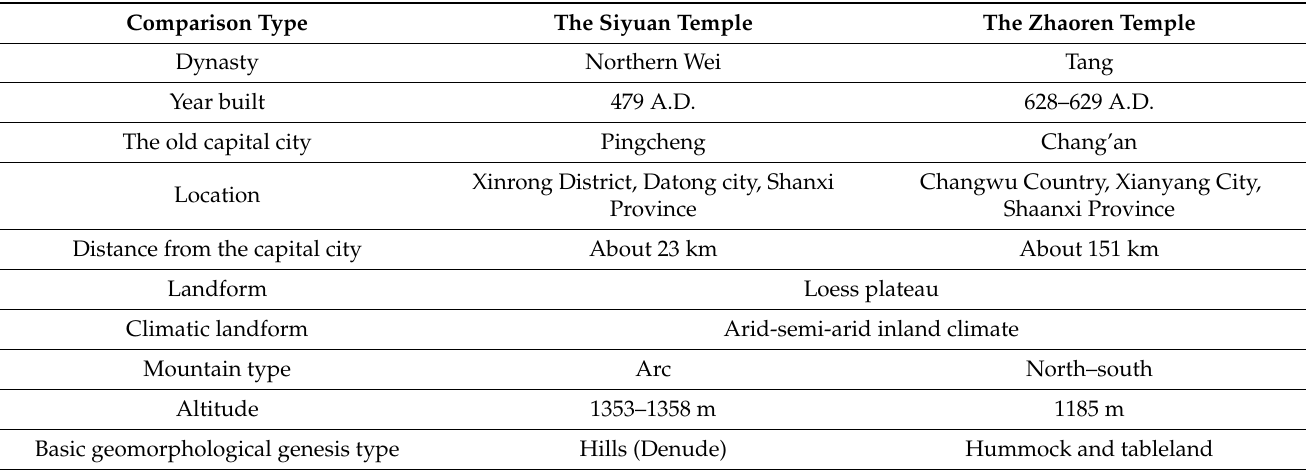
Table 1. The Modern Topography, Elevation, and Historical Geographic Information Comparison of the Two Buddhist